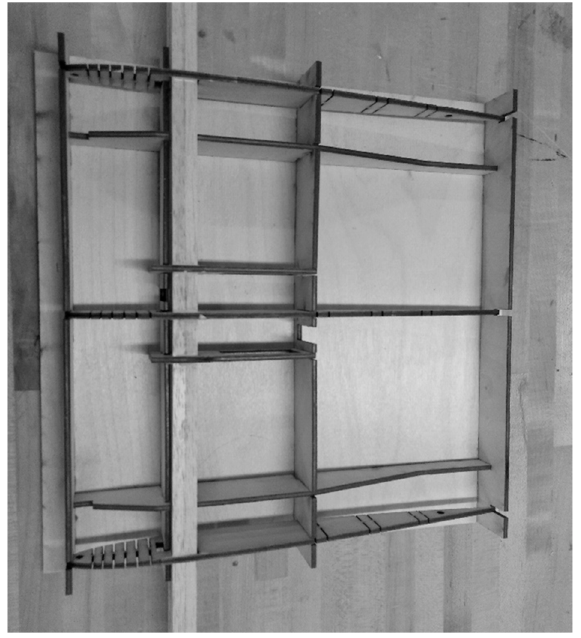
Figure 9. Morphing ribs placed in the manufacturing guide.